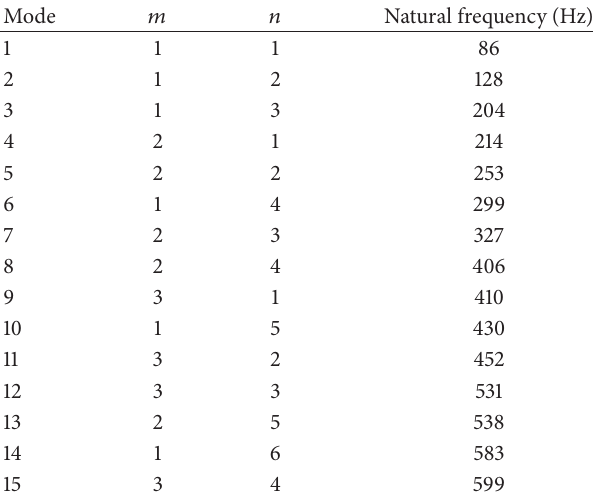
Table 3: The first fifteen natural frequencies and mode shapes for the plate described in Table 2.